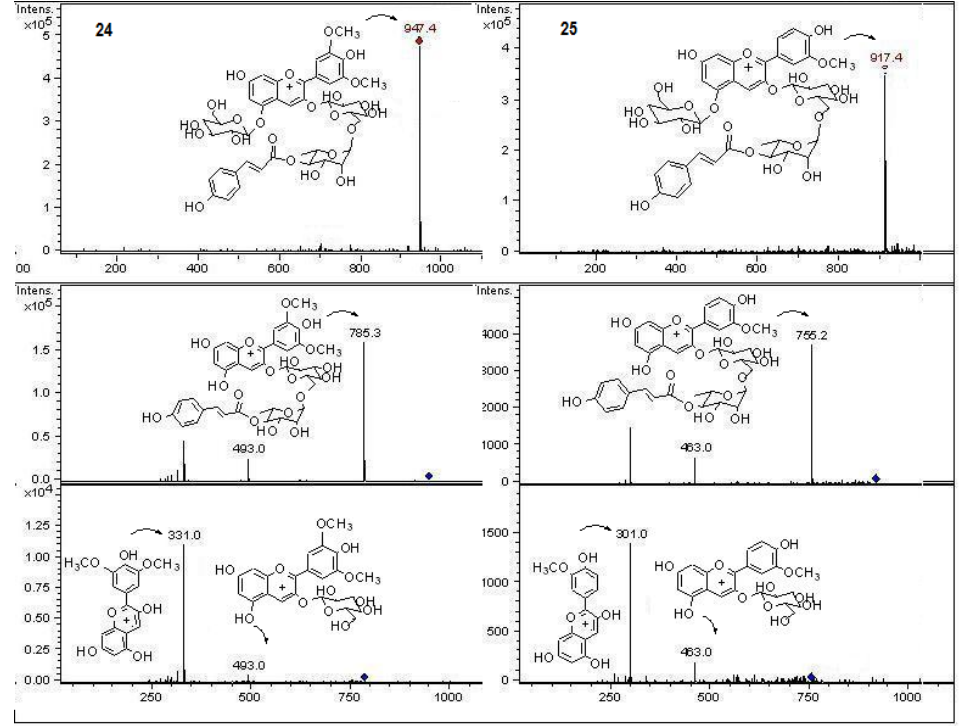
Figure 3. Structures, fragmentation, full ESI-MS and MS-MS spectra of peaks 24 , and 25 .